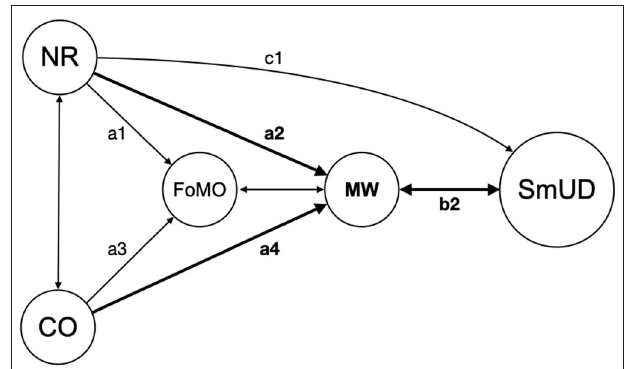
FIGURE 3 | Illustration of the significant associations between the key variables calculated by SRM including the interrelation (b2) between MW and SmUD, reinforcing each other; CO, Conscientiousness; NR, Neuroticism; MW, Mind-Wandering; FoMO, Fear of Missing Out; SmUD, Smartphone Use